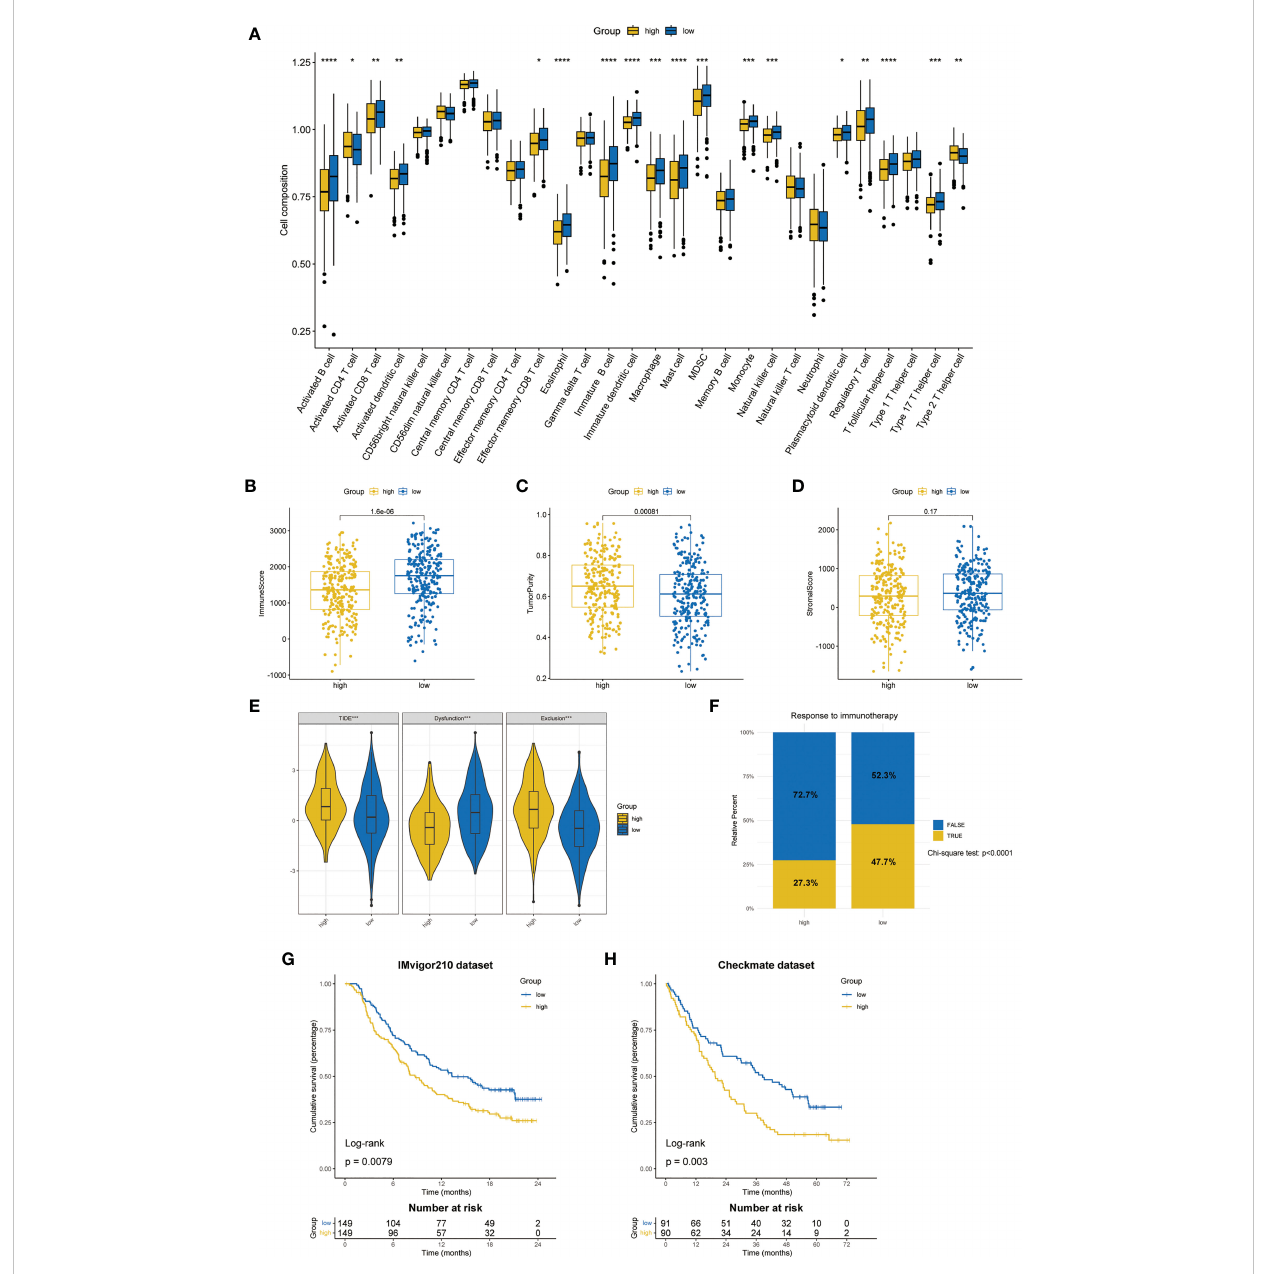
FIGURE 7 Differences in TME and prediction of immunotherapy response. (A) The differences in the proportions of 28 immune cells between two ZMRGS groups by ssGSEA. Results of immune score (B) , tumor purity (C) , and stromal score (D) in two groups. (E) The results of TIDE score. (F) Response to immunotherapy from TIDE algorithm. Kaplan – Meier analysis by ZMRGS for patients in the IMvigor210 cohort (G) and Checkmate cohort (H) . *p < 0.05, **p < 0.01, ***p < 0.001, ****p <